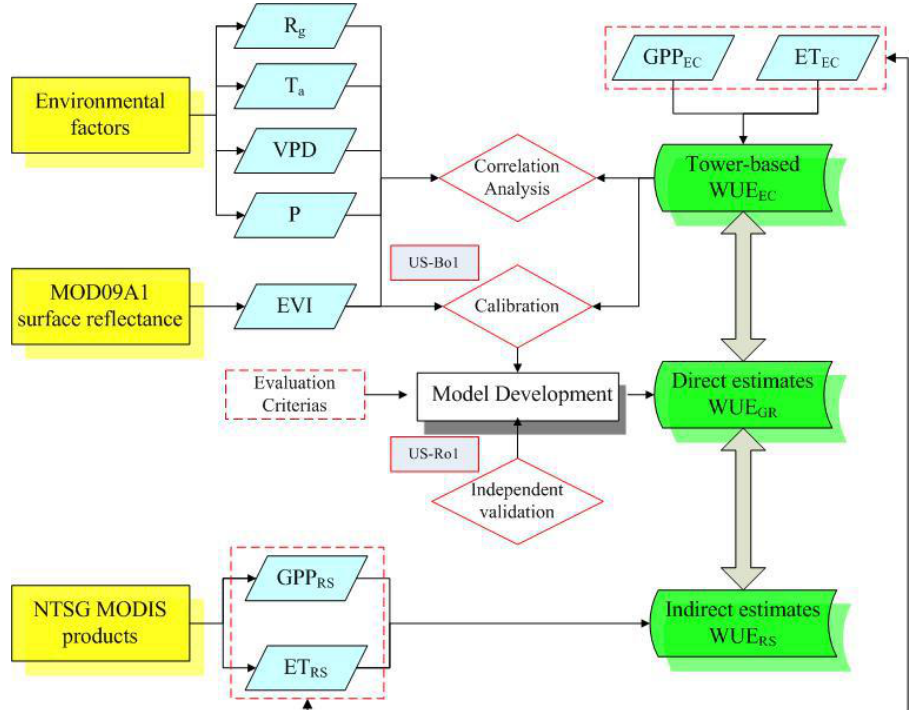
Figure 1. Overview of the research approach. R g , T a , VPD and P are observed at the flux tower sites. EVI are derived from the MODIS data. WUE EC , WUE RS , and WUE GR refer to NTSG MODIS products and the direct estimates based on MODIS EVI data,